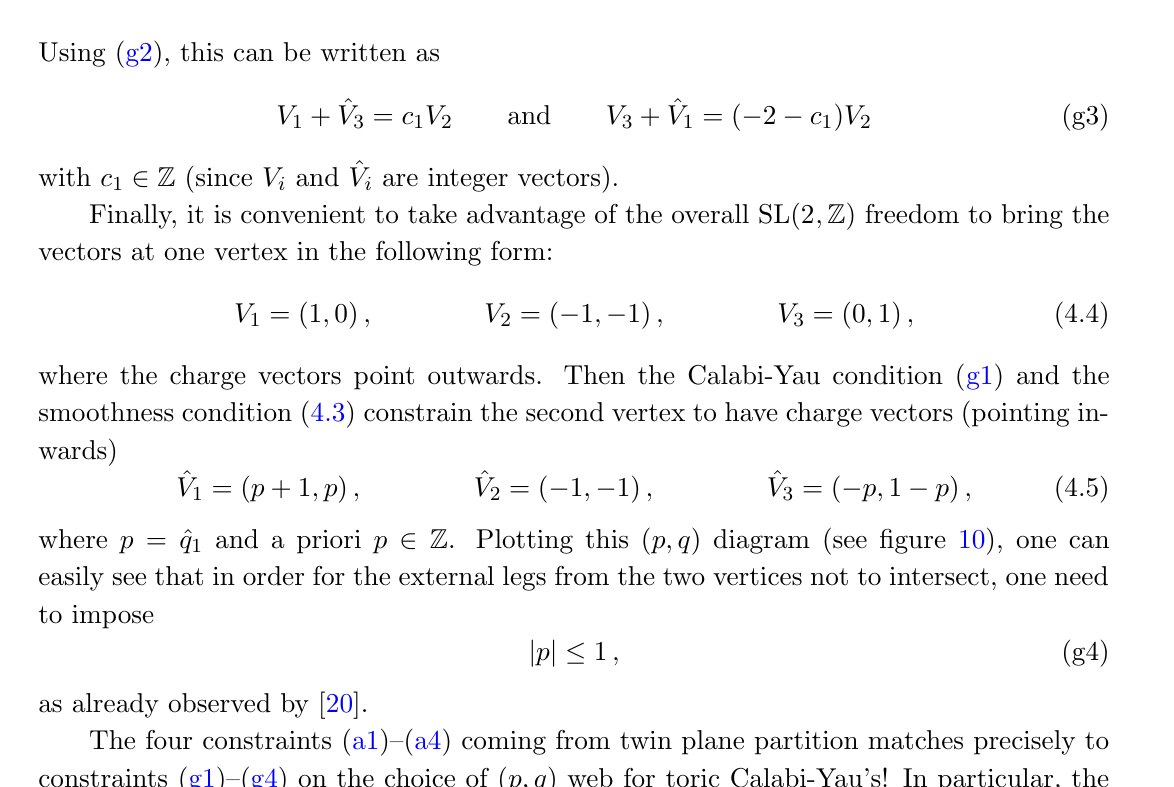
Figure 10 . Relation between coordinates x i and ^ x i for framing p . For twin plane partitions, x i 7! h i and ^ x i 7! ^ h i . For ( p; q ) web of toric geometry, x i 7! V i and ^ x i 7! ^ V i